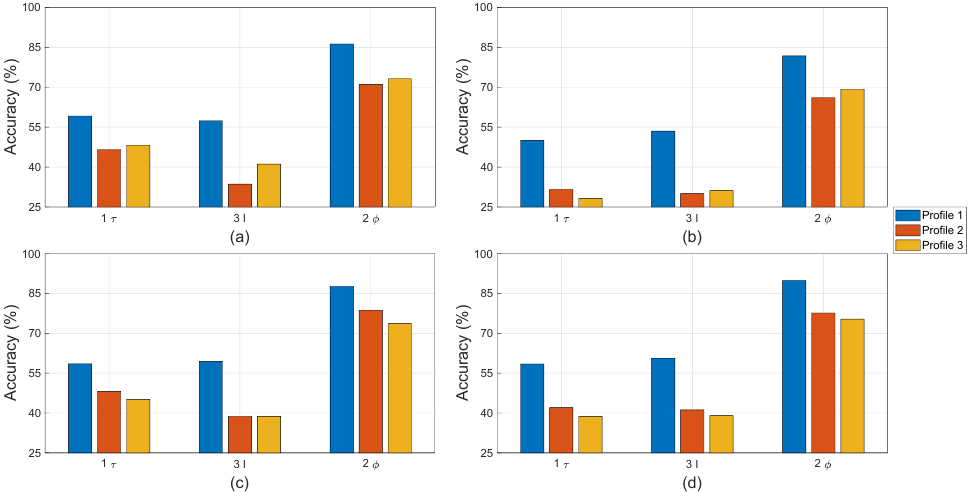
Figure 14. Classification accuracy with mixed fault obtained by ( a ) EDT, ( b ) KNN, ( c ) SVM, and ( d )